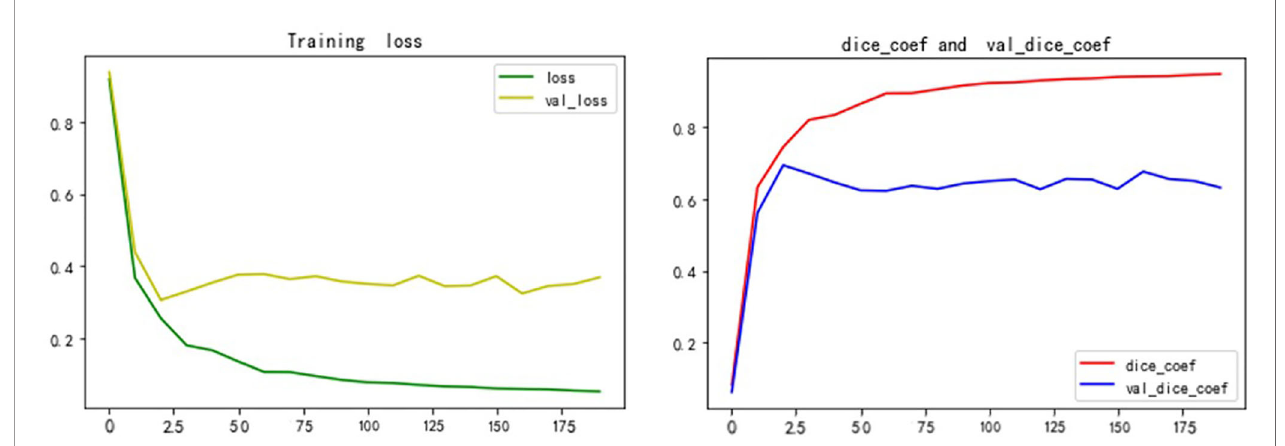
FIGURE 9 | Dice and Loss values for training and veri fi cation.